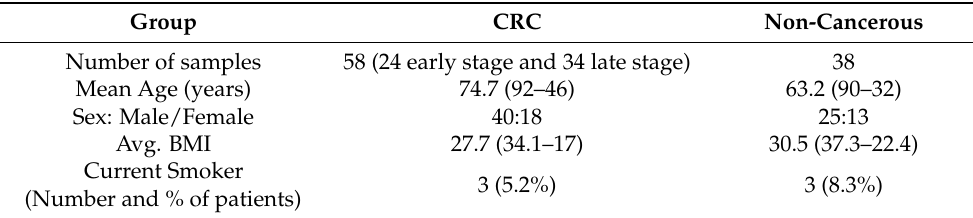
Table 1. Clinical characteristics of the recruited study participants at time of obtaining the urine